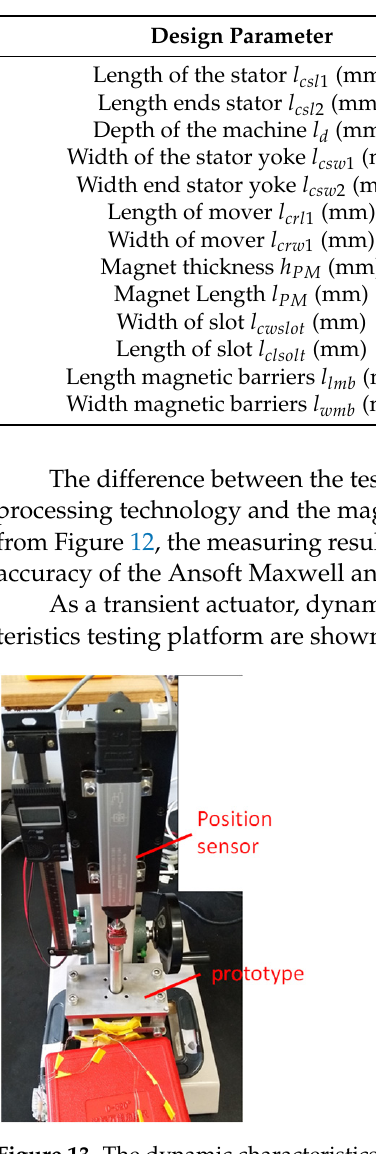
Table 3. Parameters of prototype.